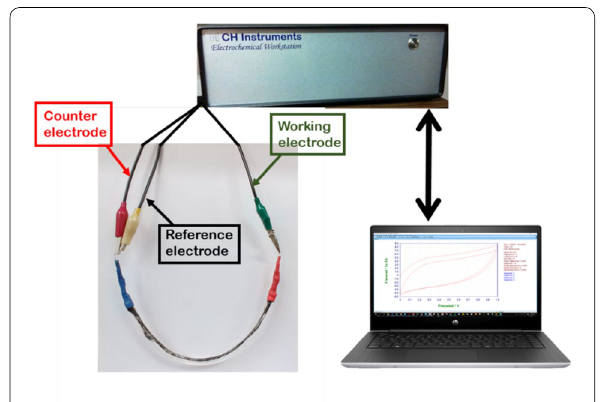
Fig. 6 Cyclic voltammetry (CV) curves: a under various scan rates, comparison between b straight and twisted position, and c before and after being coated with GFs at the scan rate of 100